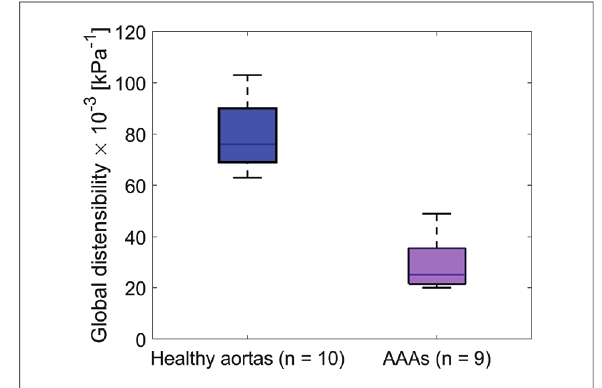
FIGURE 6 Boxplot of the global distensibility·10 − 3 (kPa − 1 ) of healthy aortas (blue) and AAAs